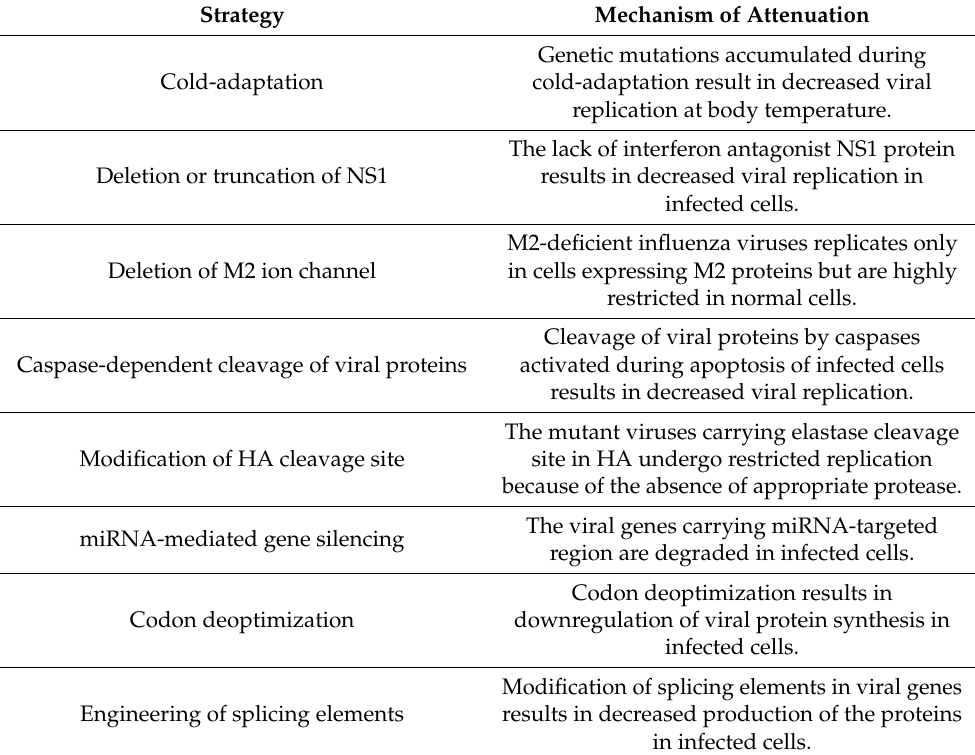
Table 1. Strategies for construction of LAIVs. Strategy Mechanism of Attenuation Genetic mutations accumulated during Cold-adaptation cold-adaptation result in decreased